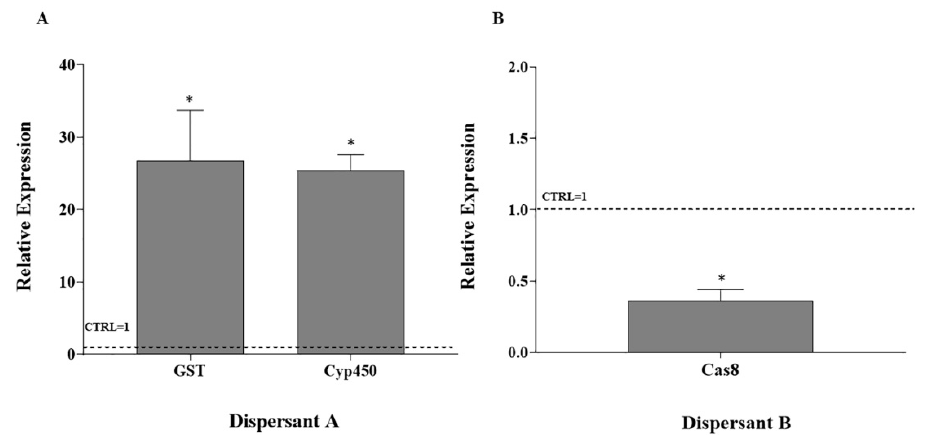
Figure 3. Expression of gst, cyp450 and cas8 genes by comparative RT q-PCR with total RNA isolated from control and exposed embryos to dispersant A ( A ) and dispersant B ( B ) after 22 hpf. Results are expressed as fold increase compared to controls assumed as 1, using cytoskeletal actin as reference gene for normalization. Each bar represents the mean of three independent experiments ± SEM. * indicates a significant difference ( t -test, p < 0.05) with respect to controls. This is the graphical representation of only significantly deregulated genes. The results of the expression of all the selected genes are reported in Figure S1.